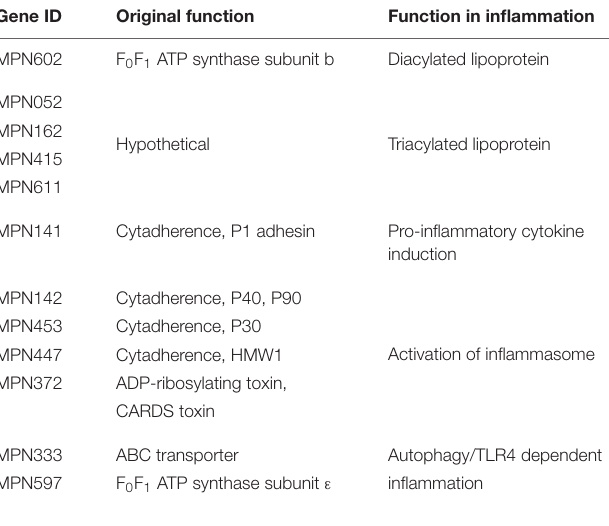
TABLE 1 | Summary of the inflammation-inducing factors of Mycoplasma